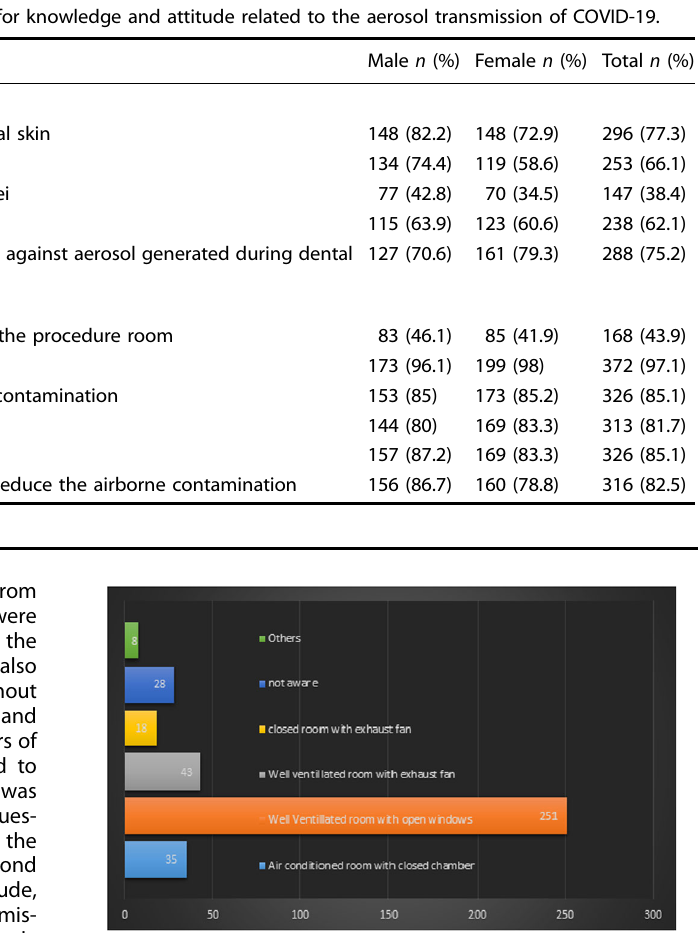
Fig. 1 Horizontal bar diagram showing distribution of responses for the current ventilation systems in their practice. Most respondents have been using a well-ventilated room with open windows in their practice. The number of respondents using each type of ventilation system is mentioned on the